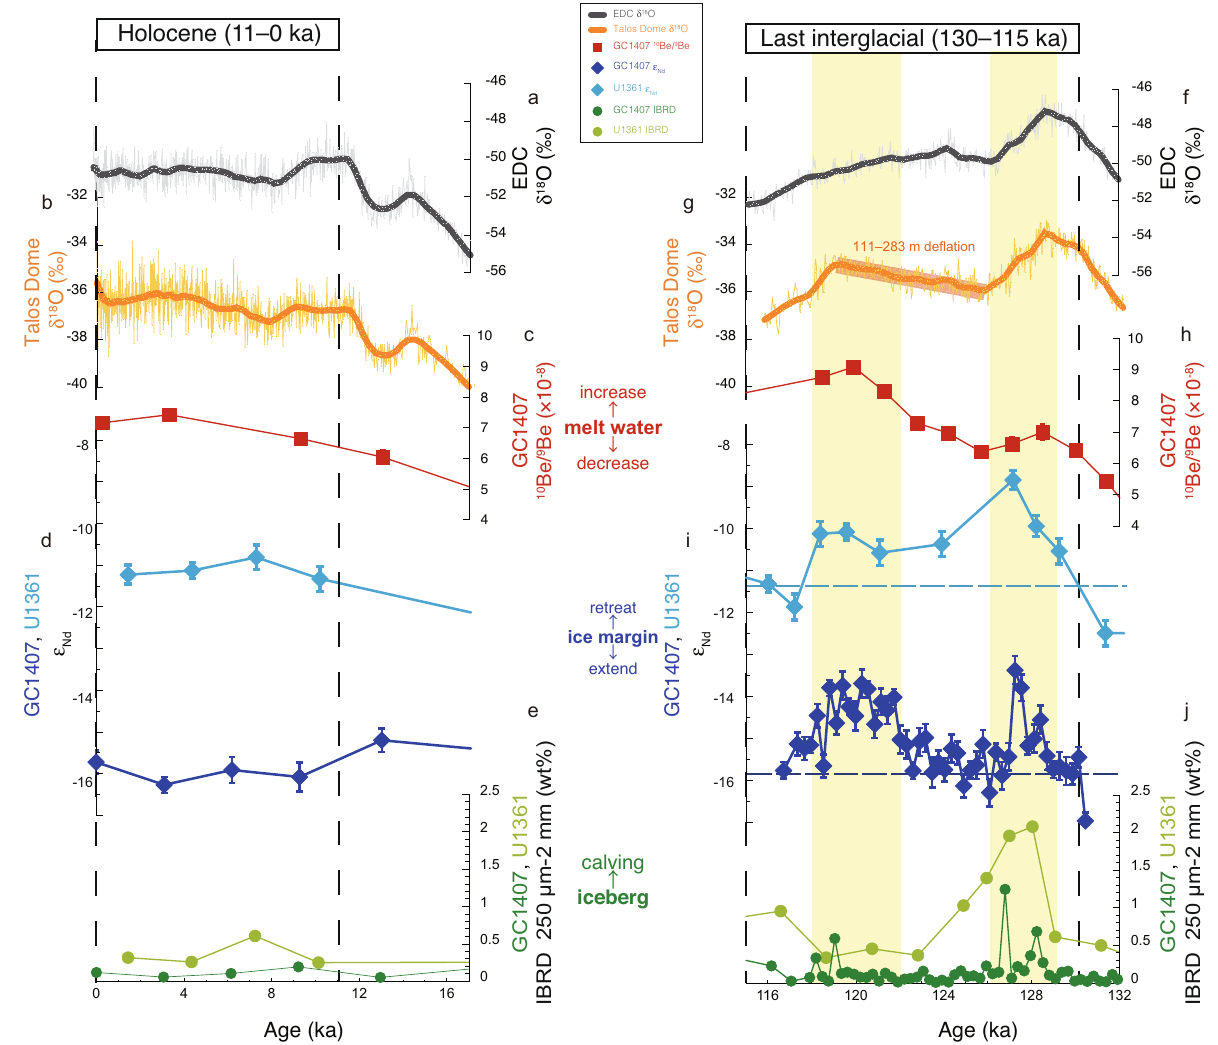
Fig. 2 | Multi-proxy evidence for variability in the Wilkes Subglacial Basin during the Holocene and Last Interglacial. a – e and f – j Multi-proxy data for the Holocene and Last Interglacial (LIG), respectively. a , f δ 18 O records from EPICA Dome C (EDC) ice core (thin and bold black lines are the raw signals and weighted smoothing, respectively) 39 . b , g δ 18 O records from Talos Dome ice core (thin and bold orange lines are the raw signals and weighted smoothing, respectively) 39 . c , h Authigenic 10 Be/ 9 Be ratios from core GC1407 (red squares, this study) (error